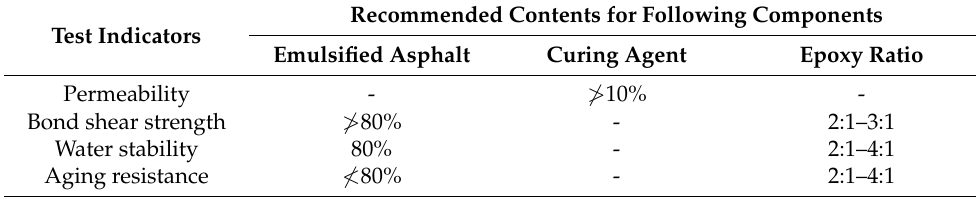
Table 5. Recommended composition contents for preparing epoxy-emulsified asphalt.